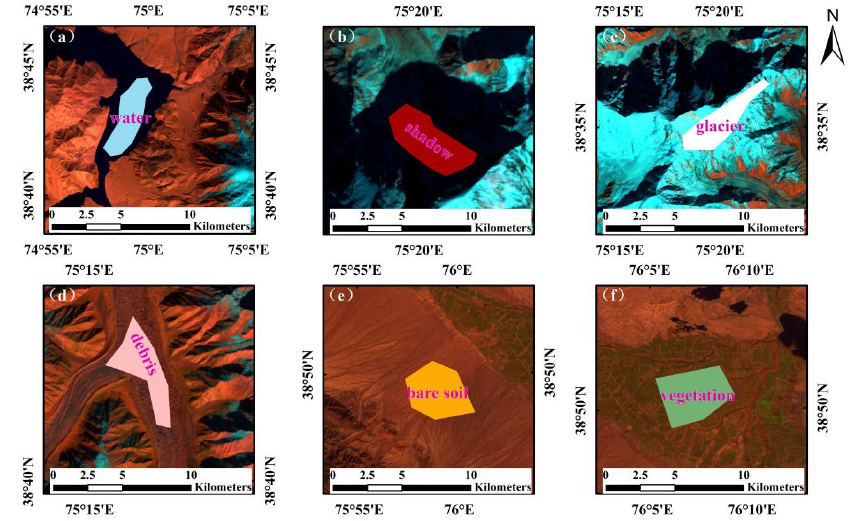
Figure 8. Different land cover classes where training samples were selected based on visual Figure8. Di ff erentlandcoverclasseswheretrainingsampleswereselectedbasedonvisualinterpretation interpretation of the Landsat‐8 image. A false‐colour composite with a band combination, R = of the Landsat-8 image. A false-colour composite with a band combination, R = shortwave infrared shortwave infrared band (band 6), G = near‐infrared band (band 5) and B = blue band (band 2). The band (band 6), G = near-infrared band (band 5) and B = blue band (band 2). The letters in rose red letters in rose red indicate water (with pattern in blue), shadow (with pattern in brown), glacier (with indicate water (with pattern in blue) ( a ), ( b ) shadow (with pattern in brown), ( c ) glacier (with pattern pattern in white), debris (with pattern in pink), bare soil (with pattern in orange) and vegetation (with pattern in green). in white), ( d ) debris (with pattern in pink), ( e ) bare soil (with pattern in orange) and ( f ) vegetation (with pattern in